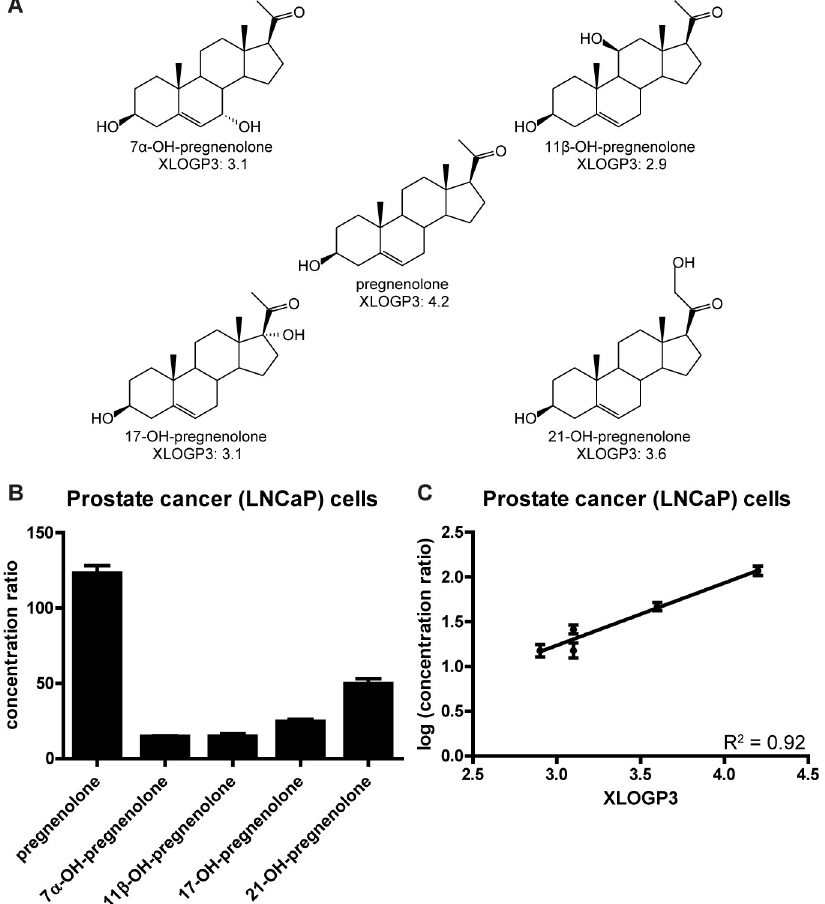
Fig 9. Modifying pregnenolone to decrease its lipophilicity results in decreased cellular uptake. (A) Structures of pregnenolone (center) and four different hydroxypregnenolones. Note the addition of a single -OH group at a different location on the structure of each hydroxypregnenolone. XLOGP3 values (computational predictions of log K ow s based on molecular structures) were obtained from PubChem. (B) Ratios of cellular concentrations to original treatment concentrations in culture media for the five steroids after treatment of LNCaP cells with 100 nM unlabeled steroid. Graph shows mean ± SD from one representative experiment with biological triplicates and the experiment was performed twice. The uptake of pregnenolone was greater than all other steroids (p < 0.001, Tukey’s multiple comparison test after one-way ANOVA). (C) Graph of logs of average cell-to-media concentration ratios vs. XLOGP3 for the five steroids. Graph shows mean ± SD from six total samples per steroid in two experiments. Slope of trendline is different from zero (p <